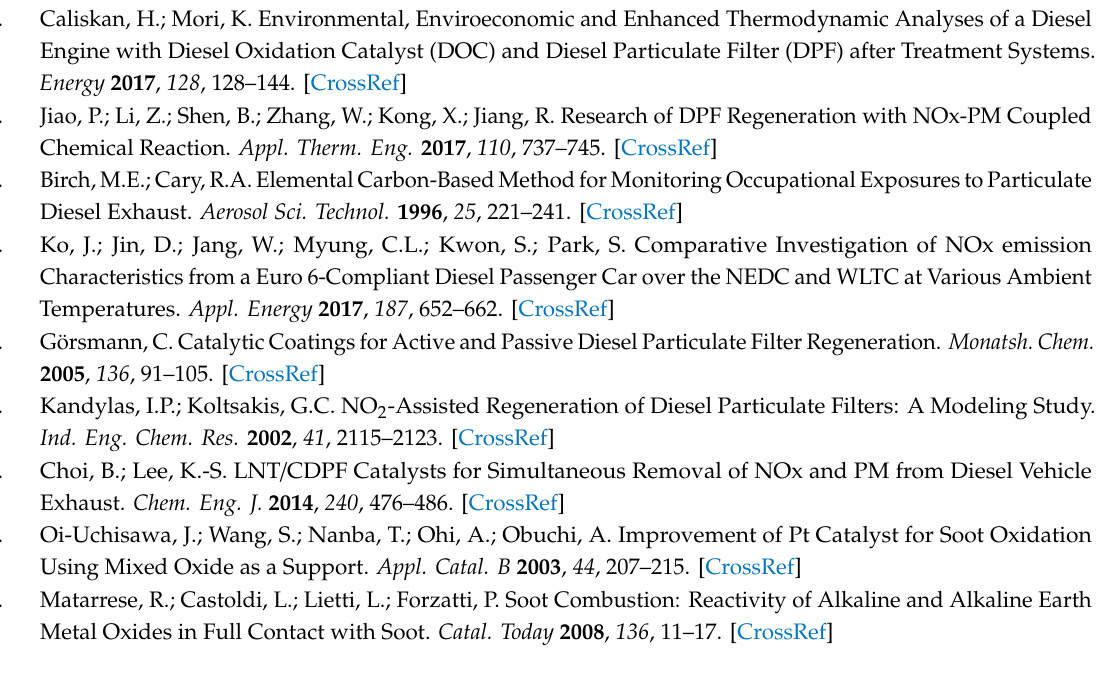
Figure S1: SEM image of the honeycomb sample; (a) Non-catalyst coating (b) catalyst coating (100 g / L), Table S1: Properties of the honeycomb using the catalyst